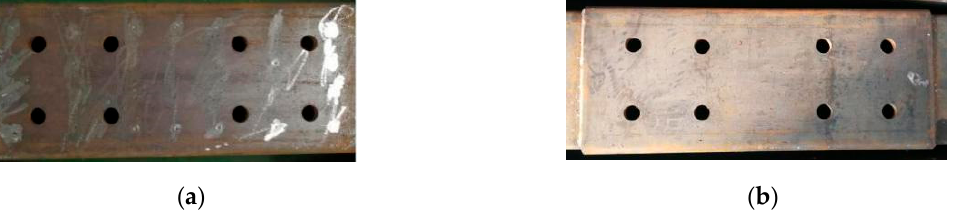
Figure 3. Connection mode of the C-channel. ( a ) With plug welding and ( b ) Without plug welding.